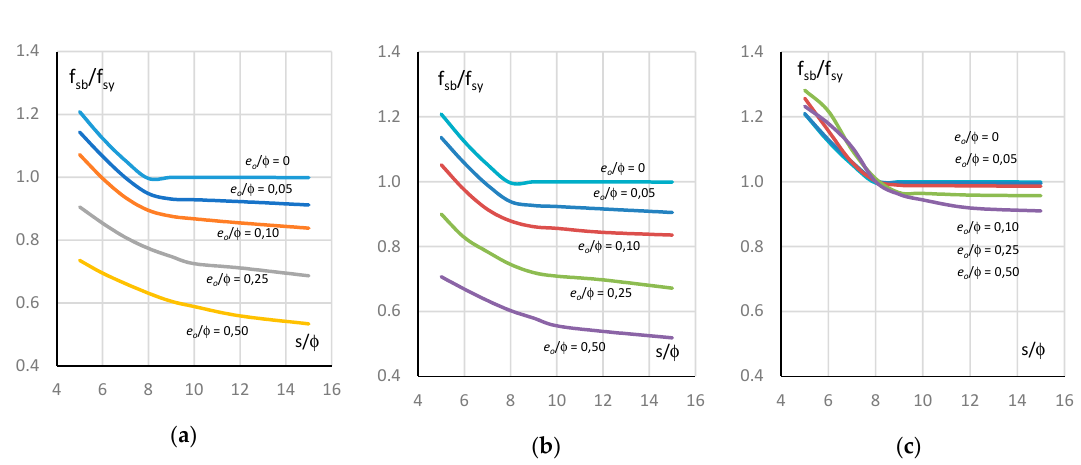
Figure 7. Normalized stress—strain curve for VD bars: ( a ) e/ ϕ = 0.05, ( b ) e/ ϕ = 0.10, ( c ) e/ ϕ = 0.25 and ( d ) e/ ϕ = 0.50.